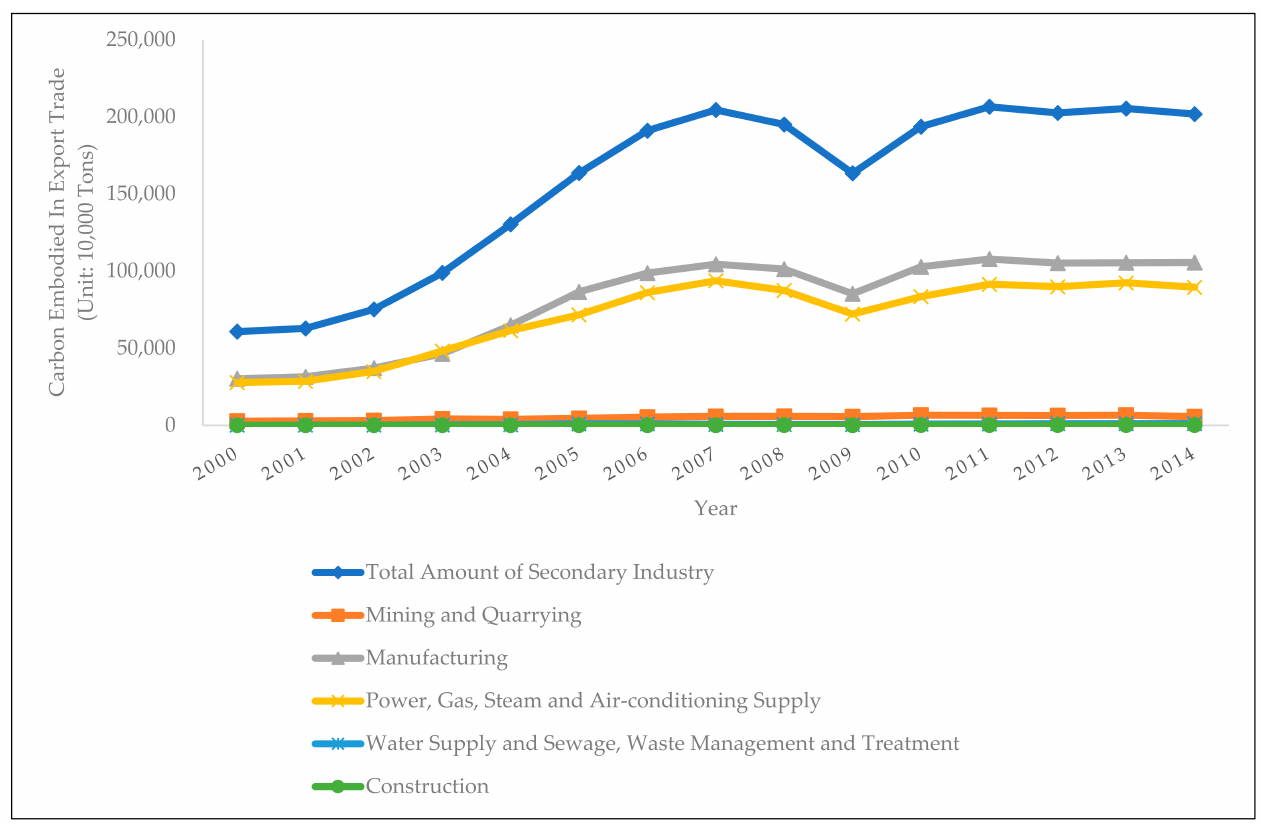
Figure 3. Embodied Carbon in the Export Trade of China’s Secondary